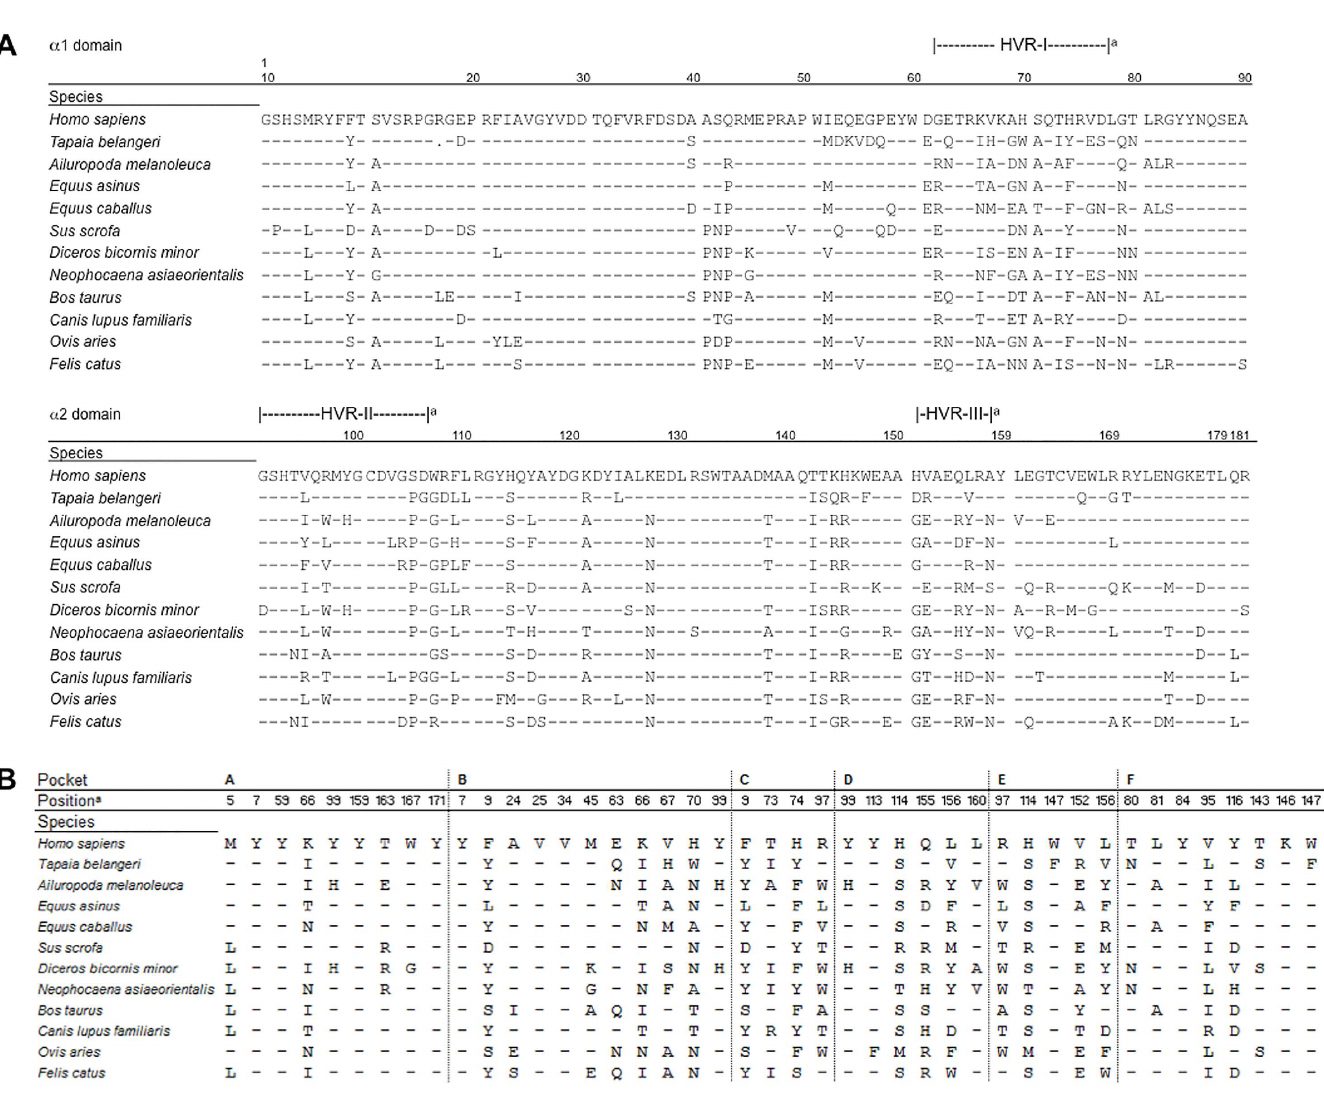
Fig 4. Alignment of MHC class I α 1 and α 2 domain amino acid sequences of selected species. (A) Alignment of MHC class I α 1 and α 2 domainamino acid sequencesof human ( Homo sapiens; AAA76608.2), tree shrew ( Tapaiabelangeri; AFM54604.1), giant panda ( Ailuropoda melanoleuca; ABY27206.1), donkey ( Equus asinus; ADE61511.1), horse ( Equus caballus; BAI45218.1), wild pig ( Sus scrofa; ACA33856.1), black rhinoceros( Diceros bicornisminor; AAD02690.1), porpoise( Neophocaena asiaeorientalis; ALB25881.1), cow ( Bos taurus; AFS51741.1), dog ( Canis lupus familiaris; NP_001014767.1),sheep( Ovis aries; AGN98174.1) and cat ( Felis catus; ACK99133.1). Identity of residues to humanHLA-A * 02:01 ( Homo sapiens; AAA76608.2) is shown by dashes, disposability of data by dots. Residuesallocatedto hypervariable regions I-III are indicatedabovethe alignment([19] a ). (B) Same as (A) but focusingon the MHC class I residues with reference to pocket A-F. The indicatedpositionsrefer to HLA-A * 02:01 [39–41] a